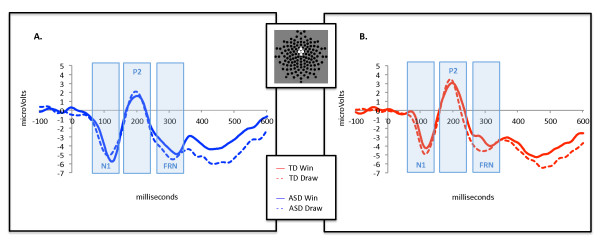
Grand averaged waveforms elicited by “win” and “draw” events in children with ASD (Panel A) and typically developing controls (Panel B).Highlighted temporal windows indicate N1, P2, and FRN components.